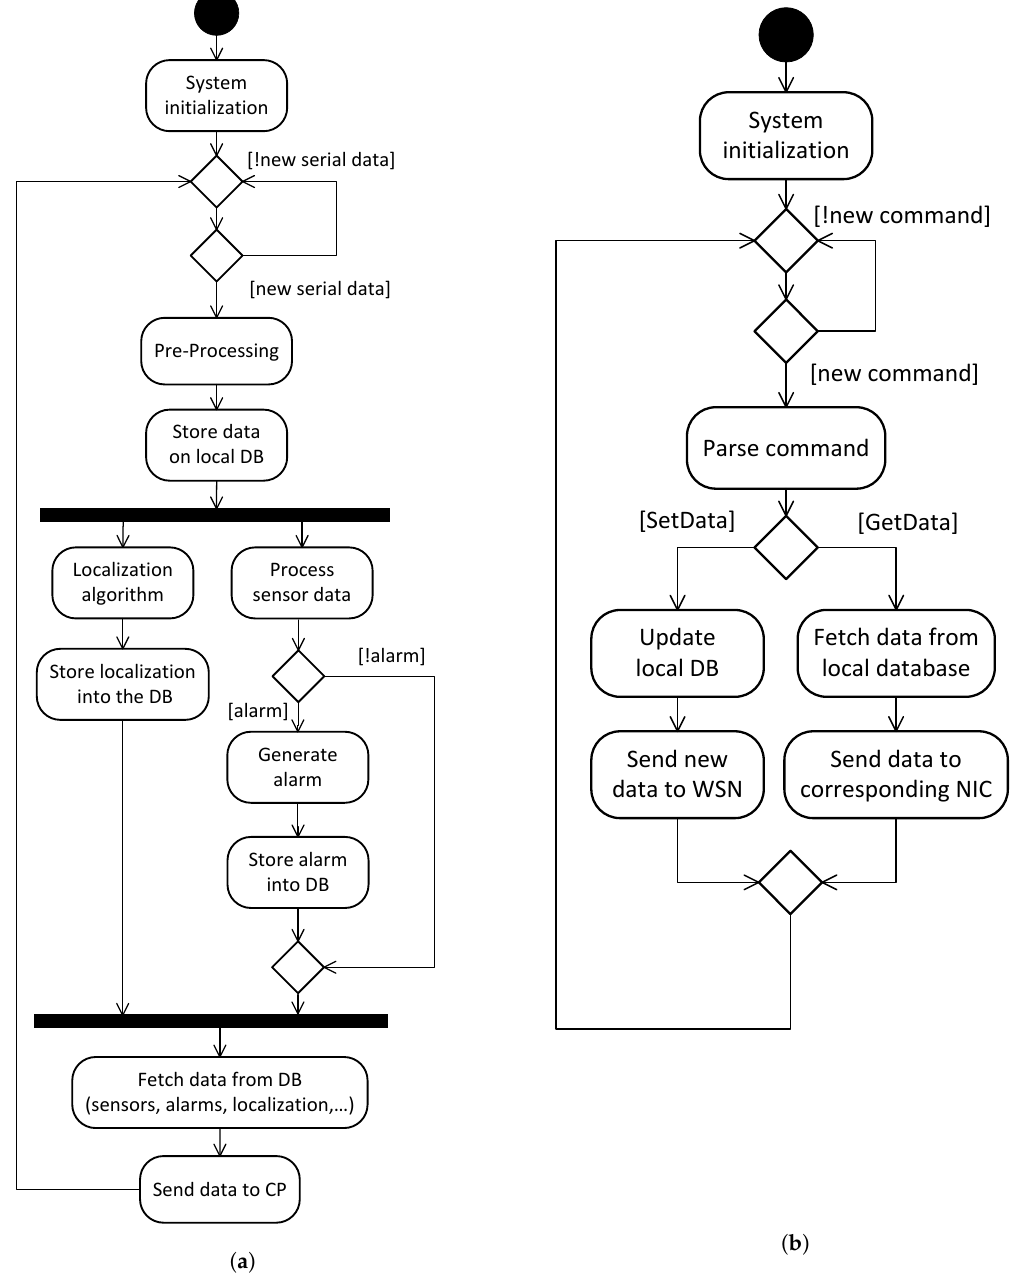
Figure 9. IoT Gateway activity diagrams. ( a ) Localization and alarm procedures. ( b ) Management